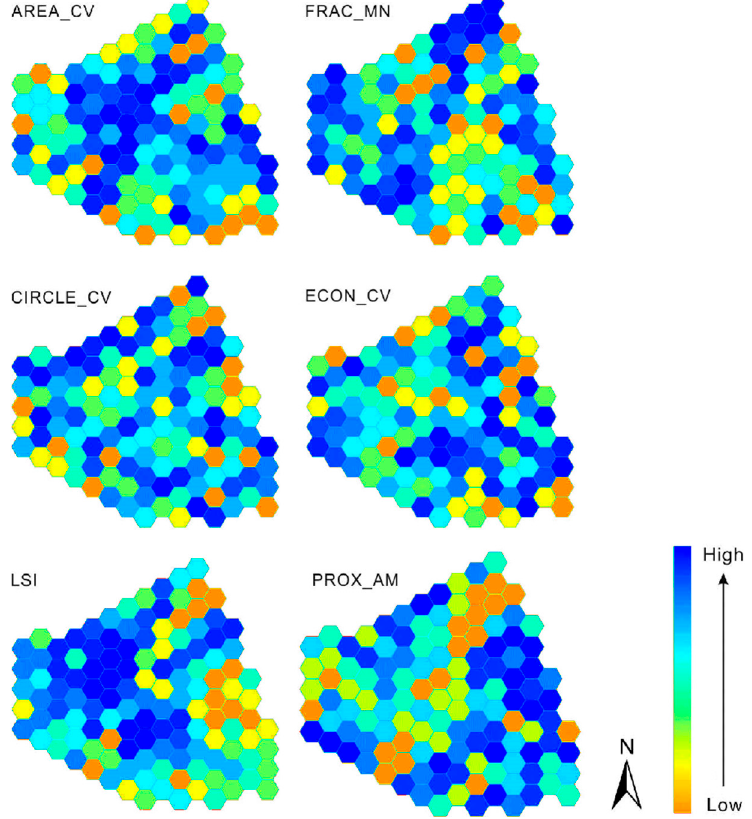
Figure 3. Value distributions of the six core metrics.